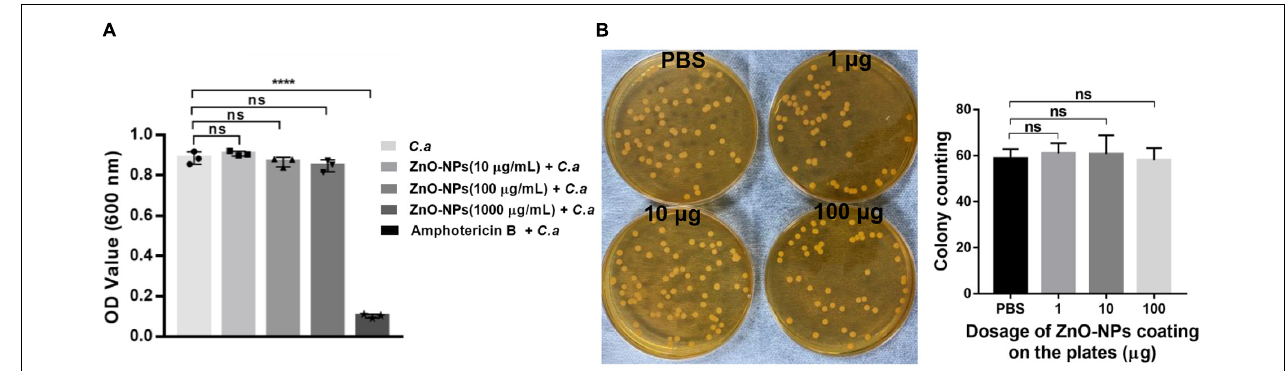
FIGURE 4 | The direct antifungal capability of ZnO-NPs against C. albicans in vitro . (A) The growth of C. albicans in YPD broth containing different concentrations of ZnO-NPs (0–1,000 µ g/ml) after overnight incubation. C. albicans incubated with amphotericin B (0.5 µ g/ml) were used as the positive control. C. albicans incubated in the absence of ZnO-NPs and amphotericin B were used as the negative control. The minimum inhibitory concentration (MIC) value was assessed by measuring absorbance at 600 nm. (B) The growth of C. albicans on YPD plates coated with ZnO-NPs. One hundred microliters of PBS solutions containing 1, 10, and 100 µ g of ZnO-NPs were evenly spread on YPD plates followed by plating with approximately 60 CFU of C. albicans and incubation at 37 ◦ C for 24 h. The same volume of PBS was coated as a control. Colonies were captured and counted for assessing the fungal growth. Each experiment was repeated in triplicate independently. Data are shown as mean ± SD. The differences in the mean values between groups were assessed using one-way analysis of variance (ANOVA)